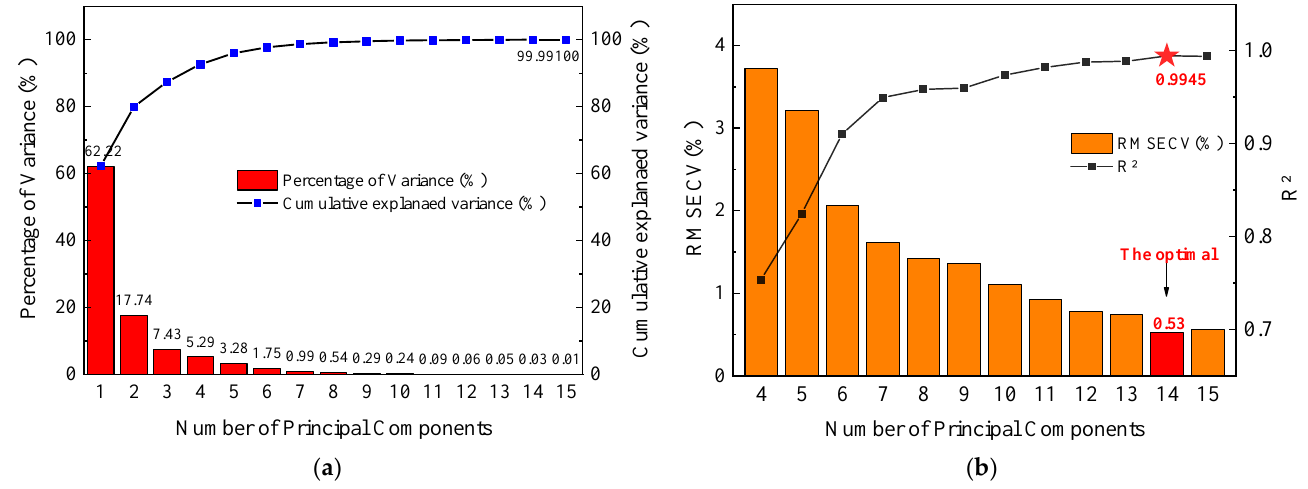
Figure 3. Scree plot ( a ) and RMSECV and R 2 values ( b ) of PCR with different numbers of principal components.